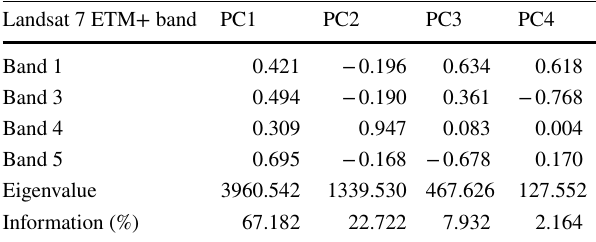
Table 2 Eigenvector and eigenvalues of PCA on bands 1, 3, 4 and 5 Landsat 7 ETM+ band PC1